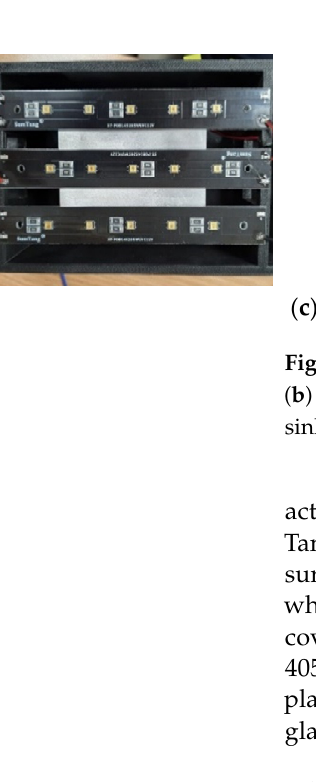
Table 2. Specifications of the UV-C, near-UV, and visible light LED modules.